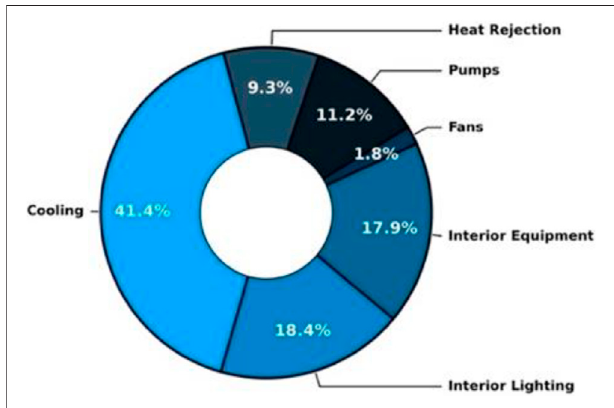
FIGURE 6 | Breakdown of building end-use categories and total consumption